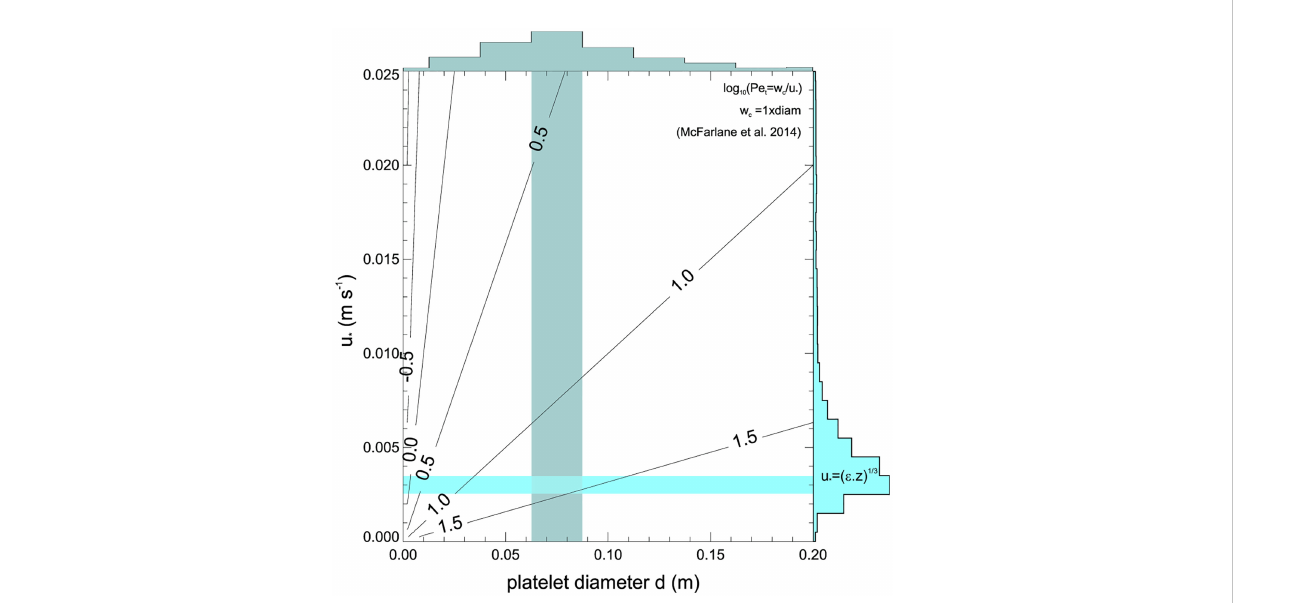
FIGURE 12 Variation of log 10 (Pe t ) as a function of platelet size (i.e. diameter) and boundary layer turbulent velocity scale u * showing approximate distribution and location of present results. The key assumption here is that the rise speed scales with diameter (see text) based on freshwater results from McFarlane et al. (2014). The diameter distribution is taken from Figure 5 and the u * distribution is from Figure 10 assuming the velocity scales with ( e z) 1/3